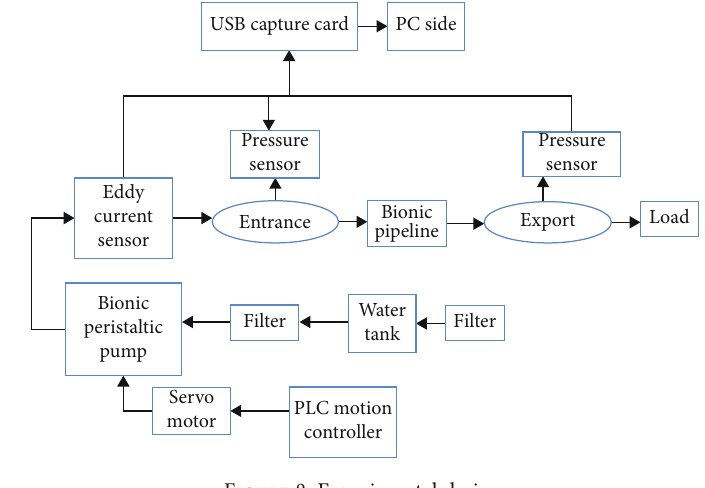
Figure 8: Experimental design.